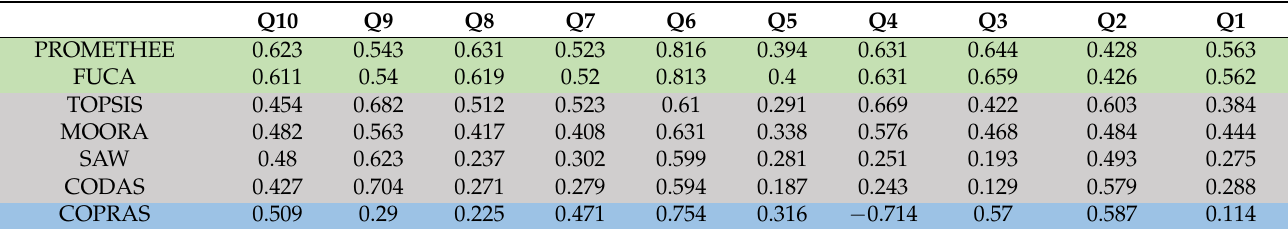
Table 9. Spearman’s Rho Coefficient between MCDM-based Financial Performance Scores and Real- Life Stock Returns (Green means the method is successful, gray means the method is mediocre, and blue means the method is